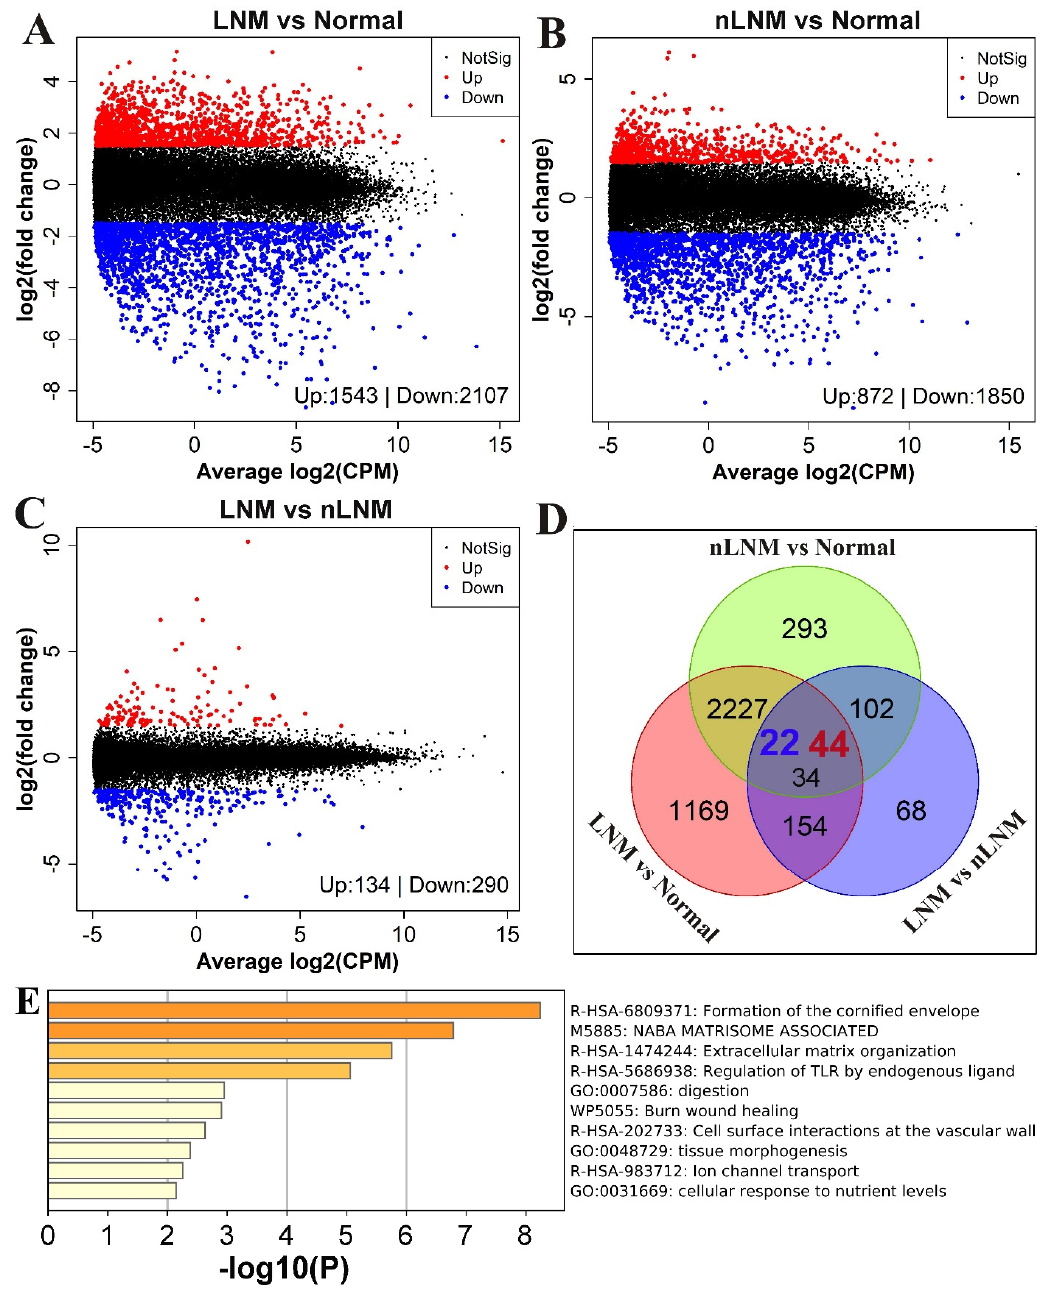
Figure 3. Differentially expressed genes between PTC with and without LNM. ( A – C ) Volcano plot showing the log2-fold changes (log 2 FC) in gene expression and their associated log2-mean expression (log 2 CPM) between normal and LNM, between normal and nLNM, and between LNM and nLNM. Red dots mark the up-regulated genes with log 2 FC > 1.5 and FDR < 0.05 and blue dots mark the down-regulated genes with log 2 FC < − 1.5 and FDR < 0.05, in each comparison. ( D ) Venn diagram of the DEGs genes identified in the three comparisons. A total of 100 DEGs were detected among 3 comparisons. Among them, 44 DEGs were up-regulated in PTC without LNM compared to normal thyroid tissues and were further up-regulated in PTC with LNM compared to PTC without LNM. Conversely, 22 DEGs were down-regulated in PTC without LNM compared to normal thyroid tissues and were further down-regulated in PTC with LNM compared to PTC without LNM. ( E ) Pathway enrichment analysis for these 66 DEGs (22 down-regulated and 44